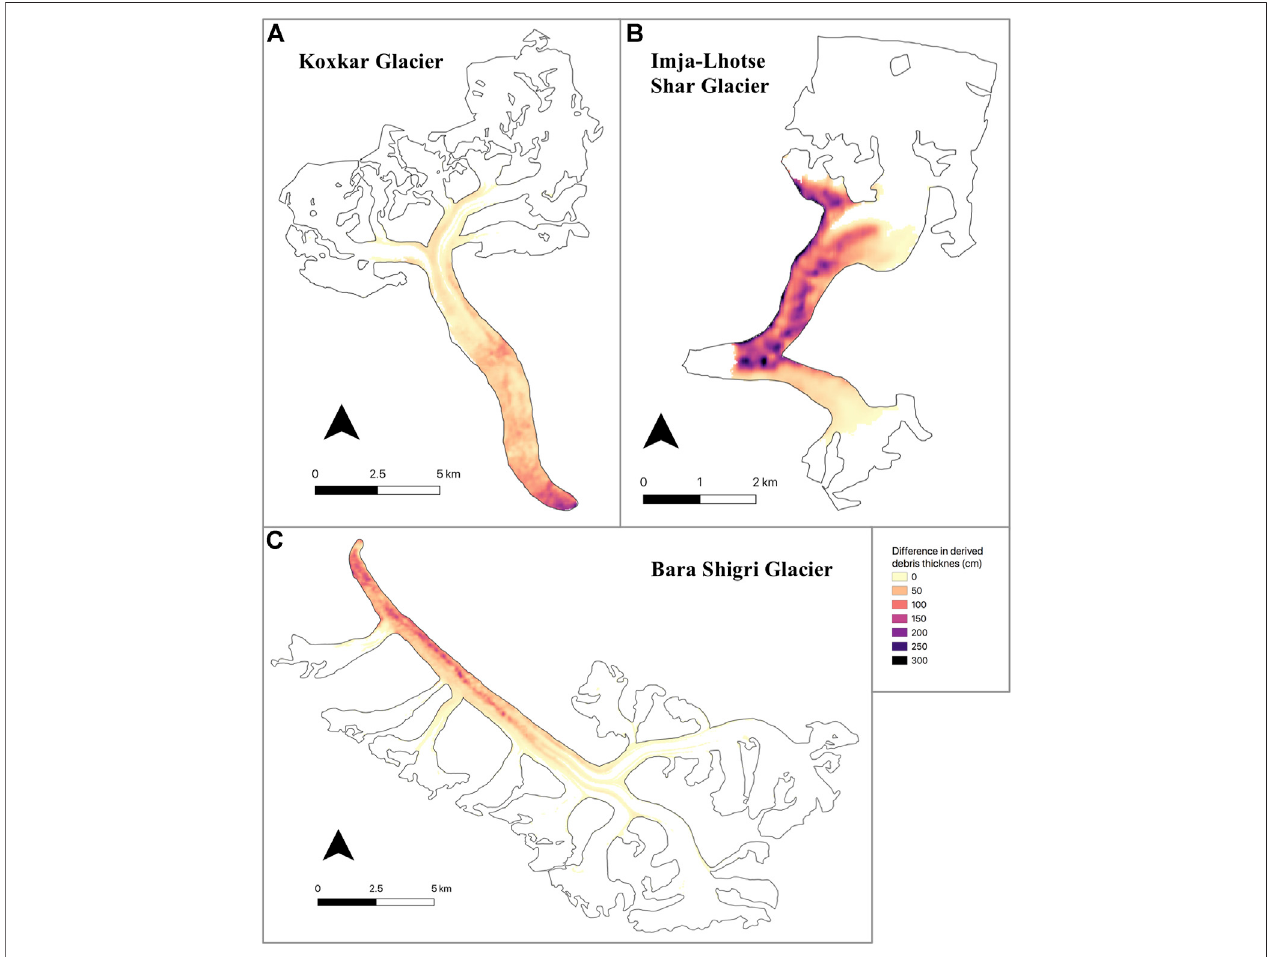
FIGURE8| The difference betweenthe debristhickness calculatedusing rationalcurve and theexponential(K) form oftheregionalscaleempirical relationship,for (A) Koxkar Glacier, (B) Imja-Lhotse Shar Glacier, and (C) Bara Shigri Glacier (difference calculated by subtracting rational curve debris thickness from exponential (K) debris